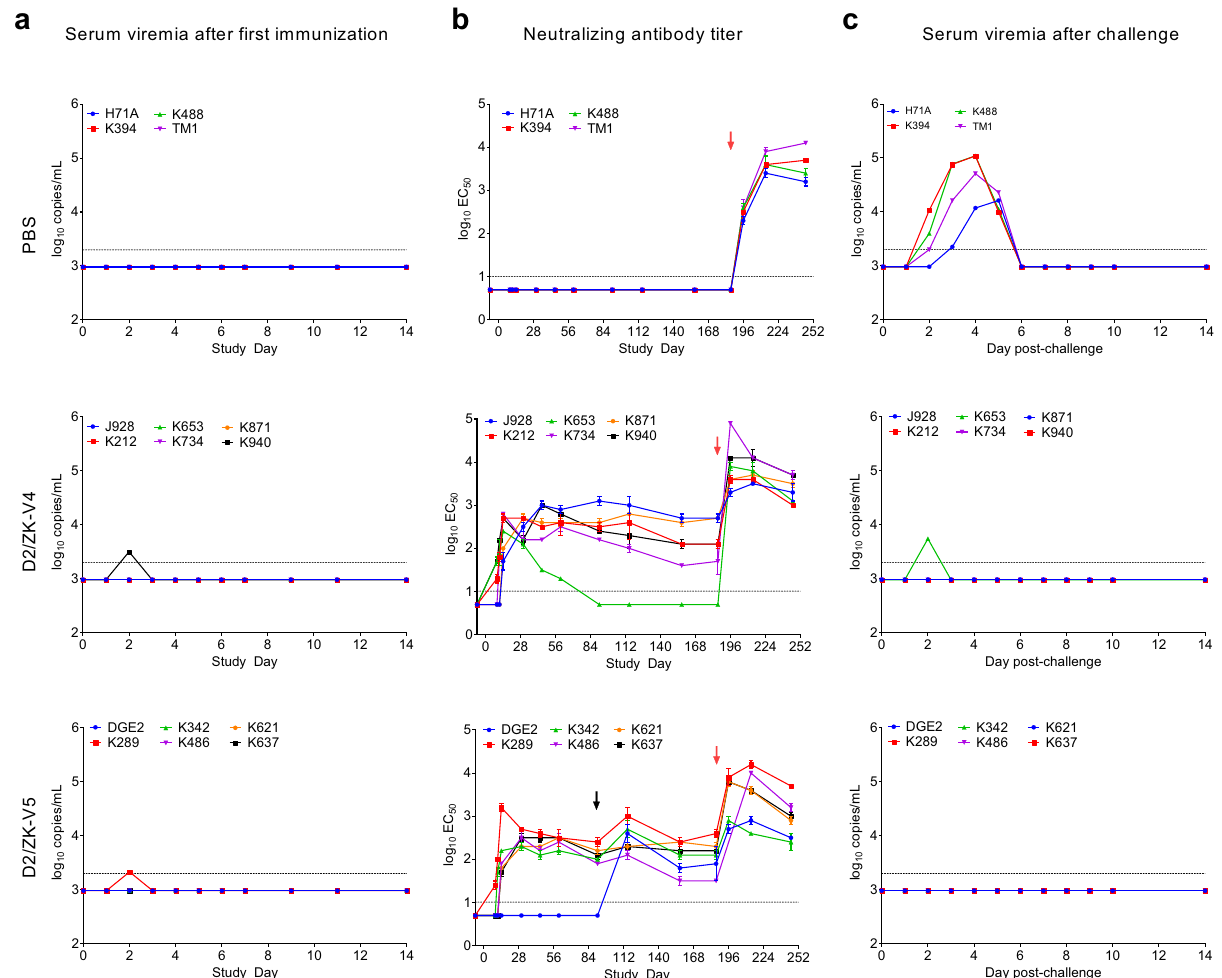
Fig. 8 D2/ZK-V4 and D2/ZK-V5 vaccination protects rhesus macaques following ZIKV challenge. Animals were immunized on day 0 (D2/ZK-V4 and -V5) and day 91 (D2/ZK-V5 group only) before challenge with 10 4 pfu of wt ZIKV on day 186. a Vaccine vRNAmia after immunization. b NAb kinetics (by R-mFRNT) after vaccination and wt ZIKV challenge. Black arrow indicates day of boost (D2/ZK-V5 group only) and red arrow indicates day of challenge. c ZIKV vRNAmia after wt ZIKV challenge. Negative samples were plotted at the half value of the assay LOQ or LOD. Dashed lines indicate assay limit of quantitation (LOQ, 3.3 log 10 copies/mL; in a and c ) or LOD (1.0 log 10 EC 50 , in b ). Graphs in a and c show the mean of qRT-PCR results from samples tested in triplicate. Graph in b represents mean and SD of 2 ( n = 2) independent titration experiments (samples were titrated in triplicate in each